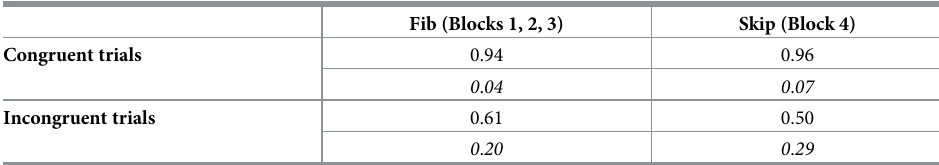
Table 6. Mean ( Standard Deviation ) accuracy for congruent and incongruent trials in Fib and in Skip (Analysis